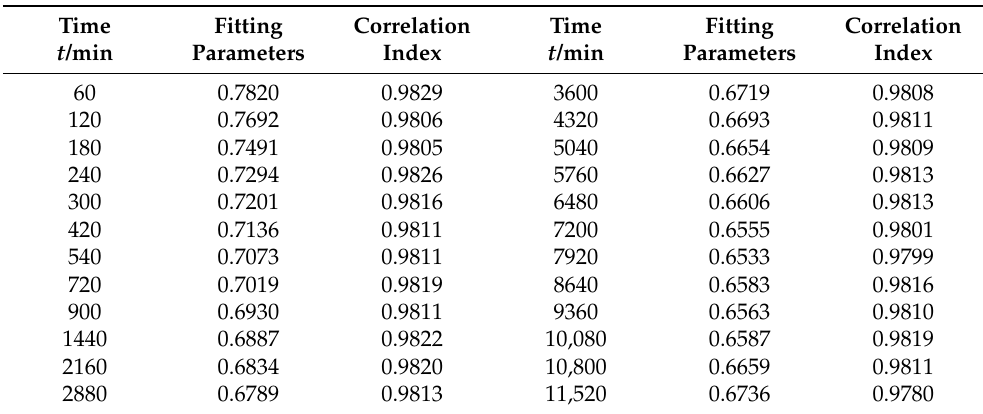
Table 11. Fitting parameters of lg σ -lg ε relation of Changsha silty clay.